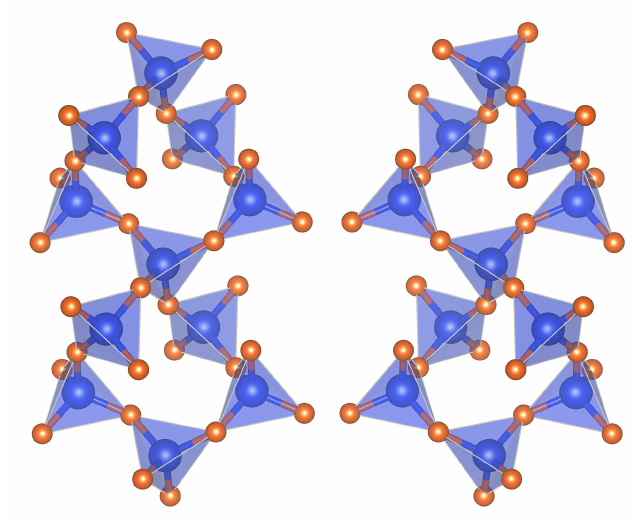
Figure 3. Right and left α -quartz